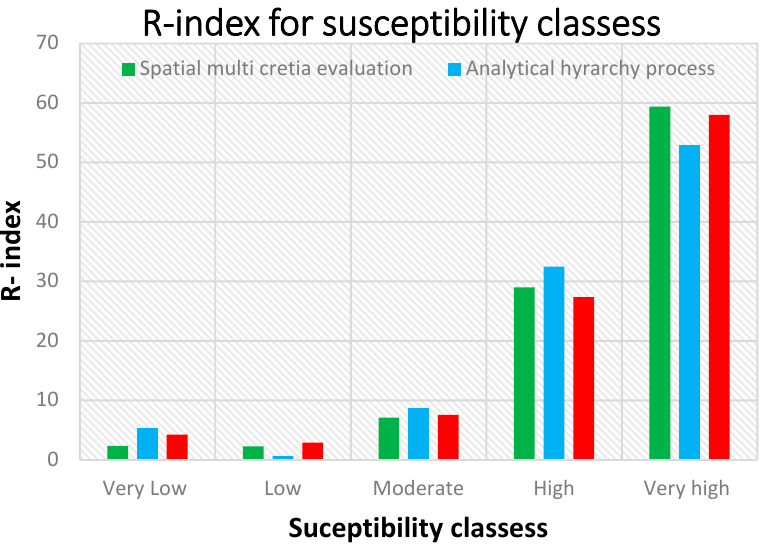
Figure 7. R-index in susceptibility classes for hybrid SMCE, AHP and FR.